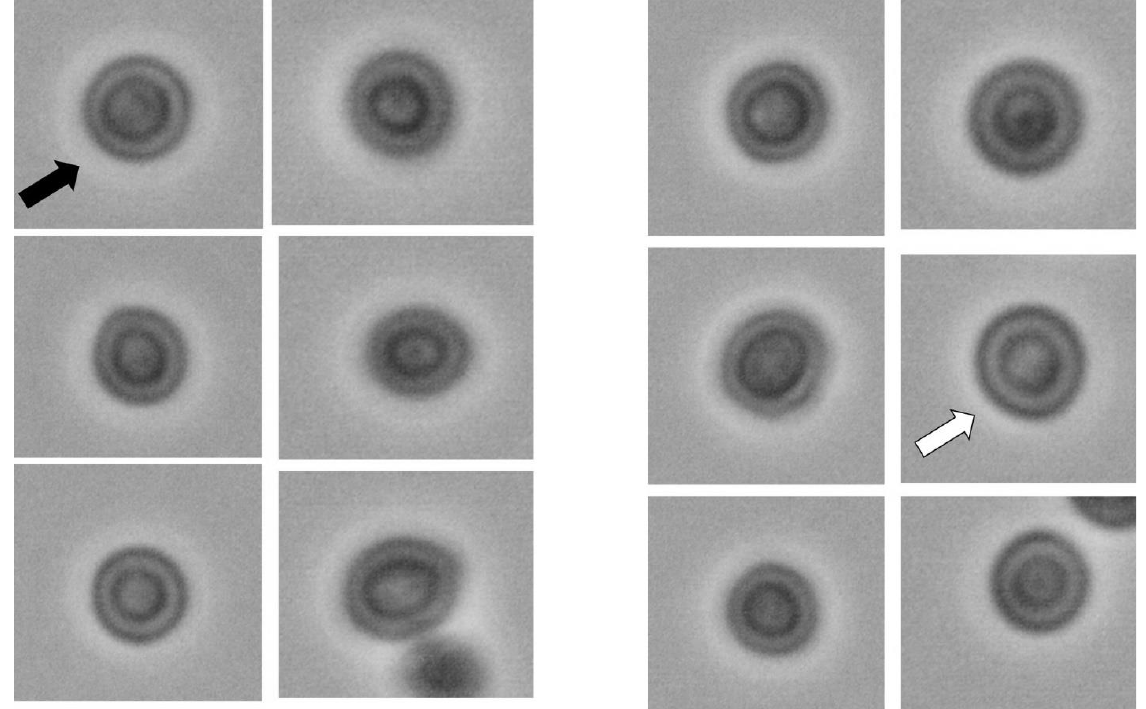
Figure 1. Saccharomyces cerevisiae yeast cells exposed to a hyperosmotic environment (right half of the image, 6 cells) and control cells (left half of the image, 6 cells). Although microscopically, no significant morphological differences can be observed, nuclear ROIs of these cells have different values of GLCM, fractal and wavelet indicators. For example, the first cell of the control group (upper left cell, marked with the black arrow) had a nuclear IDM of 0.163 and a fractal dimension of 1.551. The morphologically similar cell exposed to a hyperosmotic environment (right half of the image, marked with the white arrow) had an IDM value of 0.149 and a fractal dimension of 1.434.